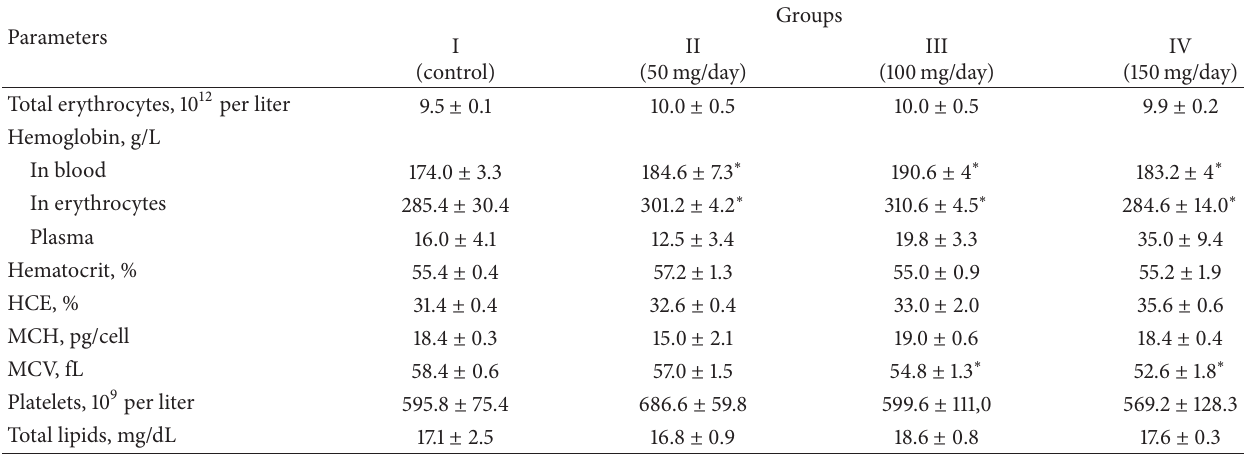
Table 1: Major parameters of the minks blood samples taken from the control (I) and experimental (II–IV) animal groups (received phenozan).